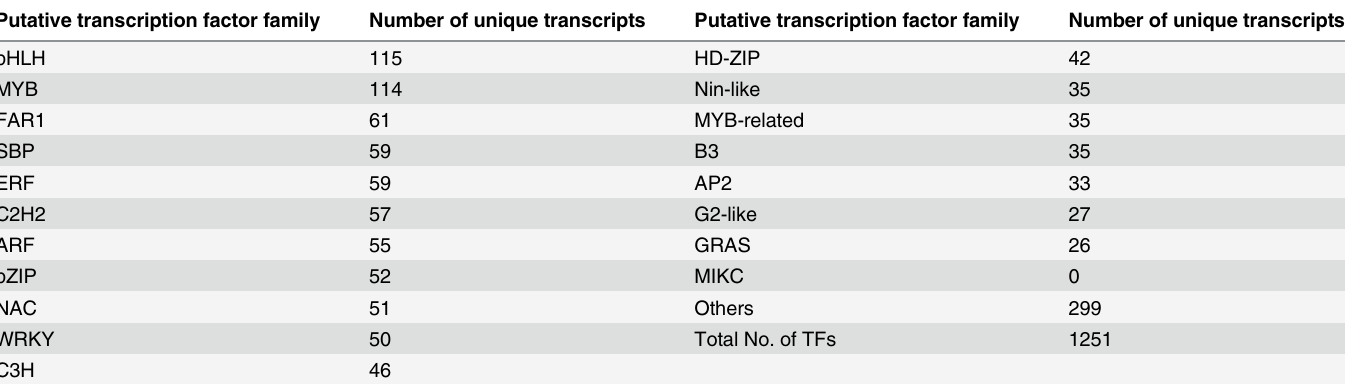
Table 4. Transcription factor families identi fi ed from ‘ Hangbaishao ’ transcriptome libraries. Putative transcription factor